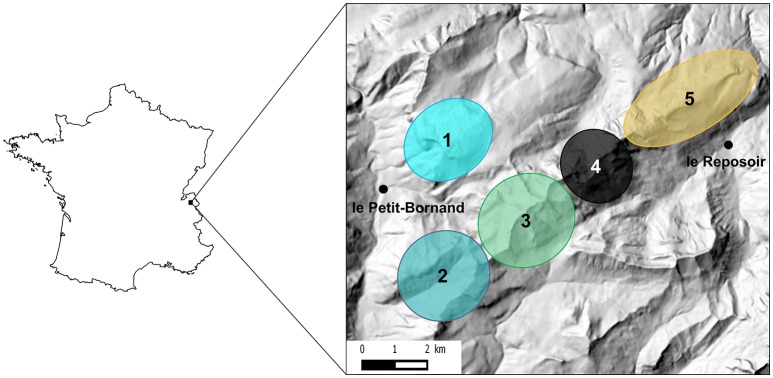
Location of the study area in France and approximate localization of the five socio-spatial units identified in Marchand et al. (2017). These five socio-spatial units correspond to the best number of spatially-segregated groups as determined by hierarchical classification methods on distances between individuals measured as overlap between annual home ranges of GPS-collared female Alpine ibex. See Marchand et al. (2017) for details.